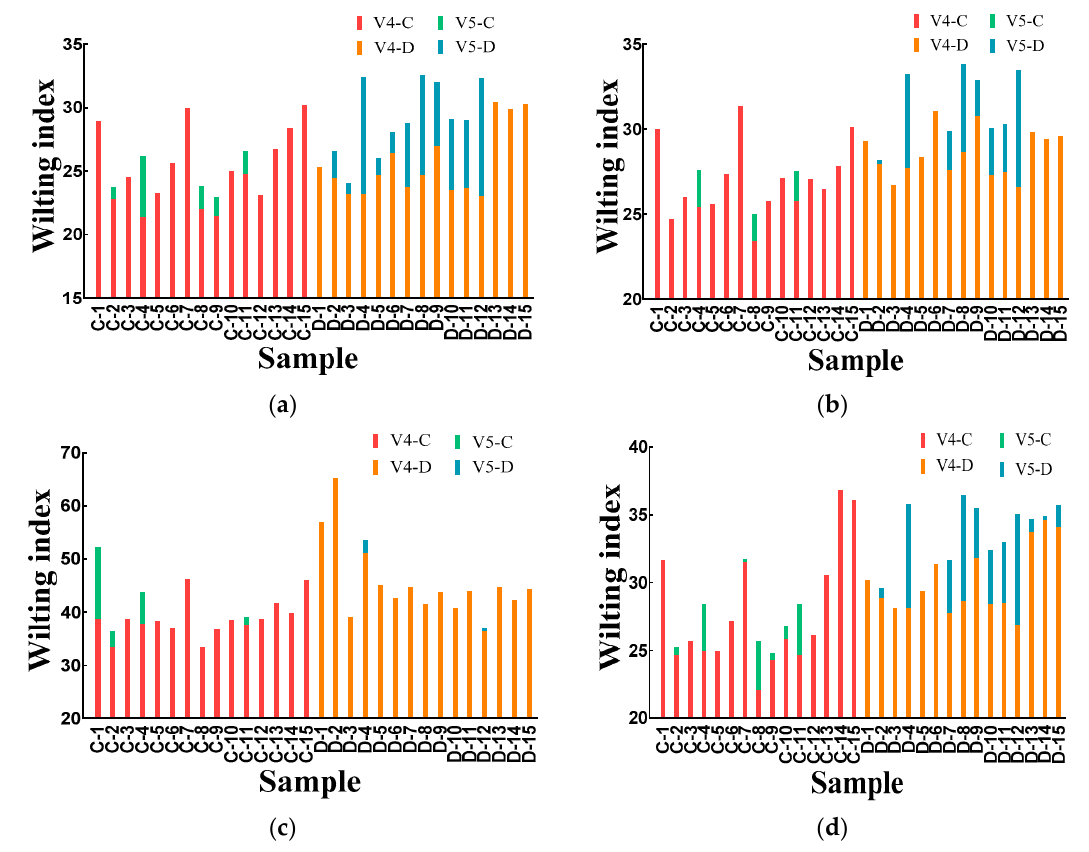
Figure 18. Wilting index of multispectral images of the soybean canopy under normal treatment and drought treatment: ( a ) wilting index in the GRE channel, ( b ) wilting index in the NIR channel, ( c ) wilting index in the RED channel and ( d ) wilting index in the REG channel.